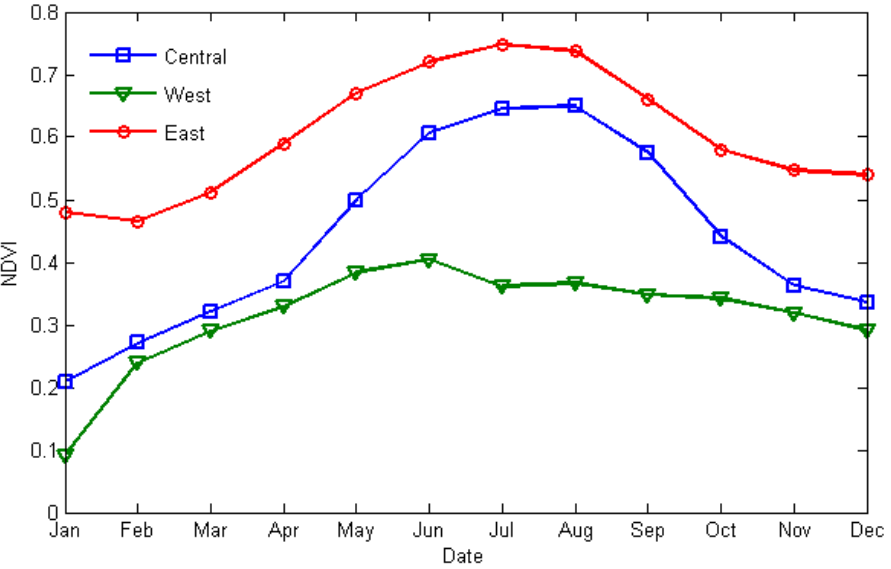
Figure 13. The temporal variation of averaged normalized difference vegetation index (NDVI) for sample sites in different spatial regions.